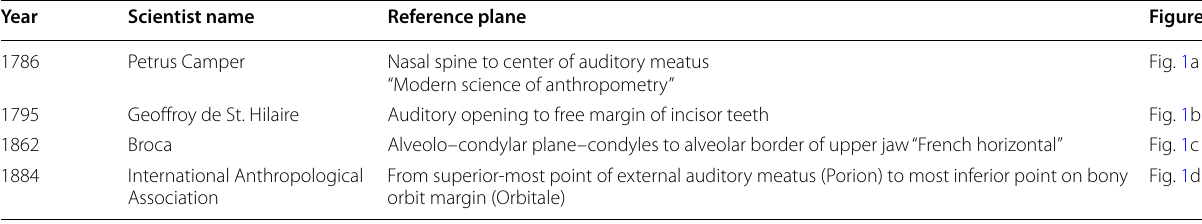
Table 1 Evolution of reference planes (Teja and Teja 2013)